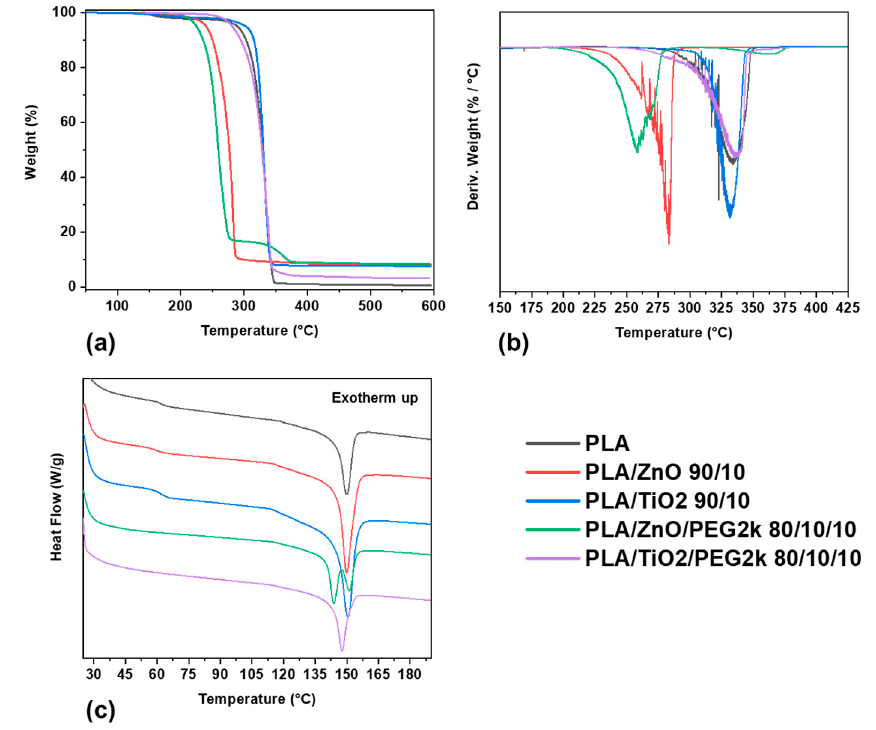
Figure 5. Thermograms of selected filaments: ( a ) T g A; ( b ) derivative of T g A; and ( c ) DSC (exotherm up) of the first heating